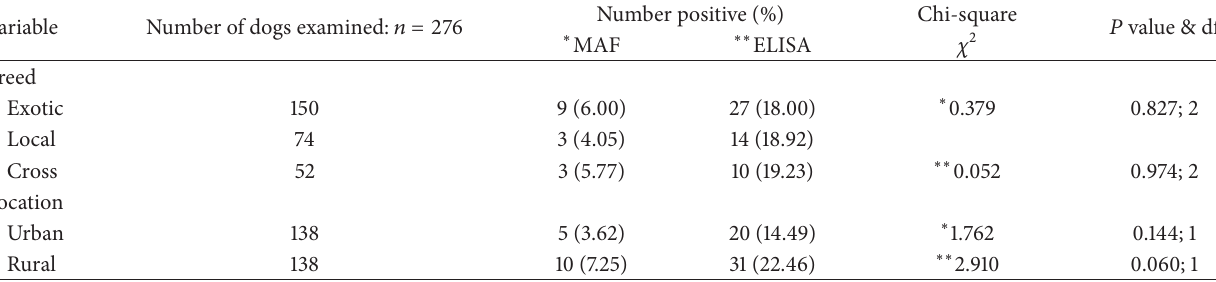
Table 5: Effect of breed and location on the prevalence of Cryptosporidium infection in dogs using ELISA and MAF in the FCT, Abuja. Variable